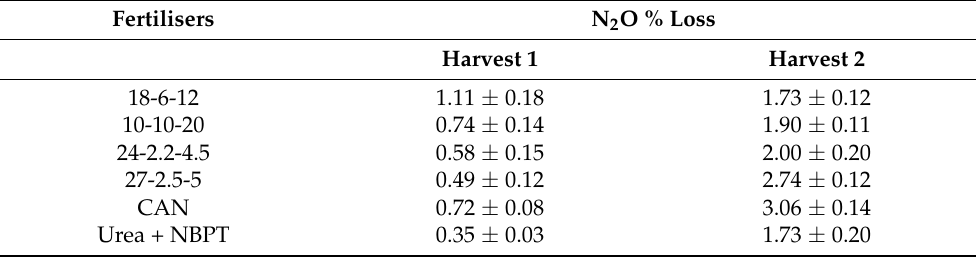
Table 3. Mean percentage and standard errors of fertiliser lost as N 2 O (N 2 O %) for the six fertiliser treatments at two